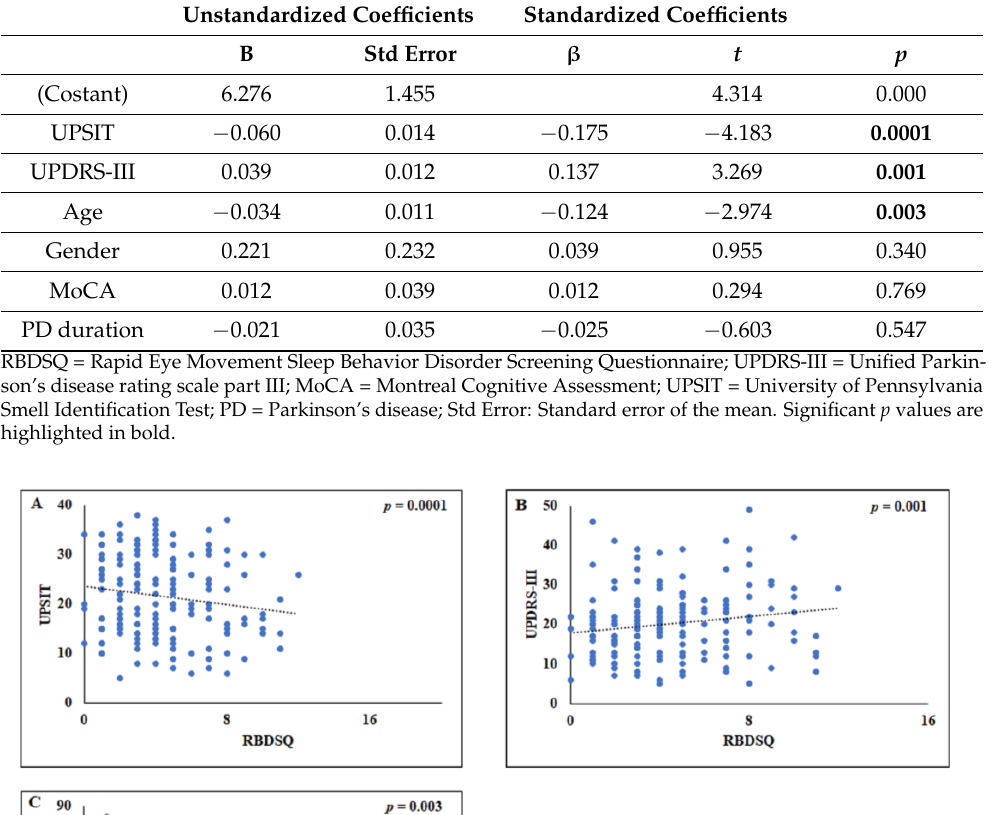
Table 3. Multivariate linear regression analyses using RBDSQ as a dependent variable and age at observation, gender, PD duration, UPDRS-III, UPSIT score and MoCA score as independent variables. Unstandardized Coefficients Standardized Coefficients